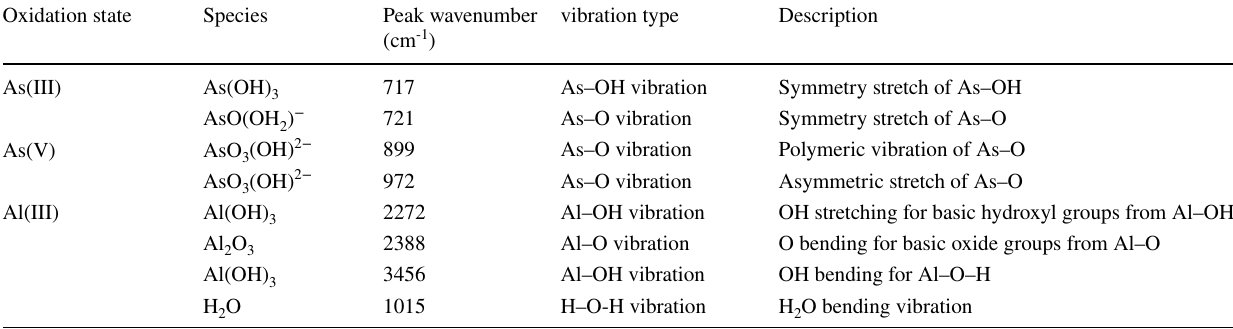
Table 4 FTIR-ATR peaks observed in the resultant sludge and their corresponding vibration type and wavenumbers Oxidation